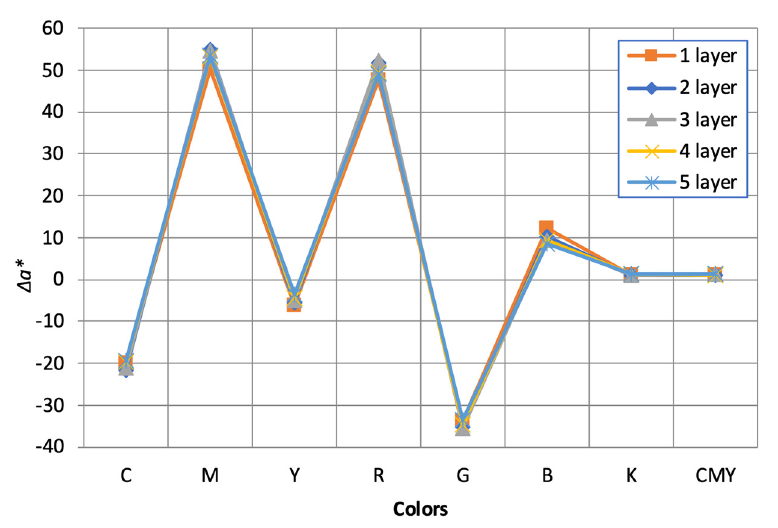
Figure 9. Different colors changes of Δ a * value depending on ink layer when printing in 4 passes.